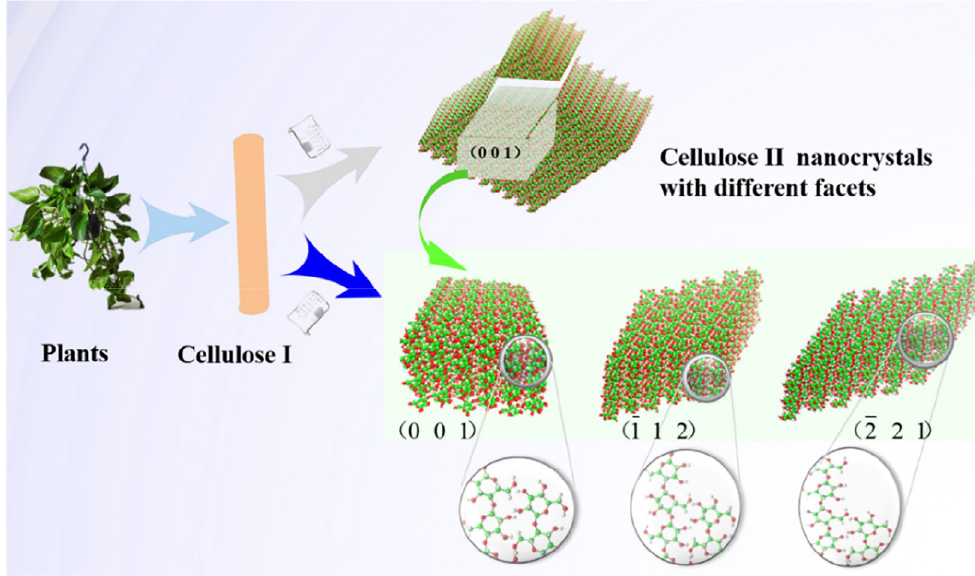
Figure 1. Cellulose II nanocrystals with different exposed facets. Cellulose I represent the native material in plants, from which Cellulose II can be synthesized. The facet (0 0 1) is the primary crystal facets of cellulose II nanocrystals, ( 1 1 2 ) and ( 2 2 1 ) are the inclined facets of cellulose II.